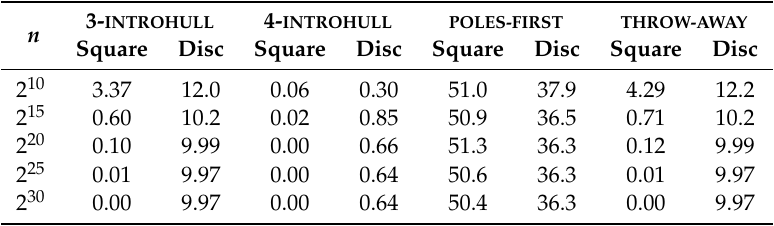
Table 3. The average number of points left after the elimination [%] for different strategies for the two data sets.